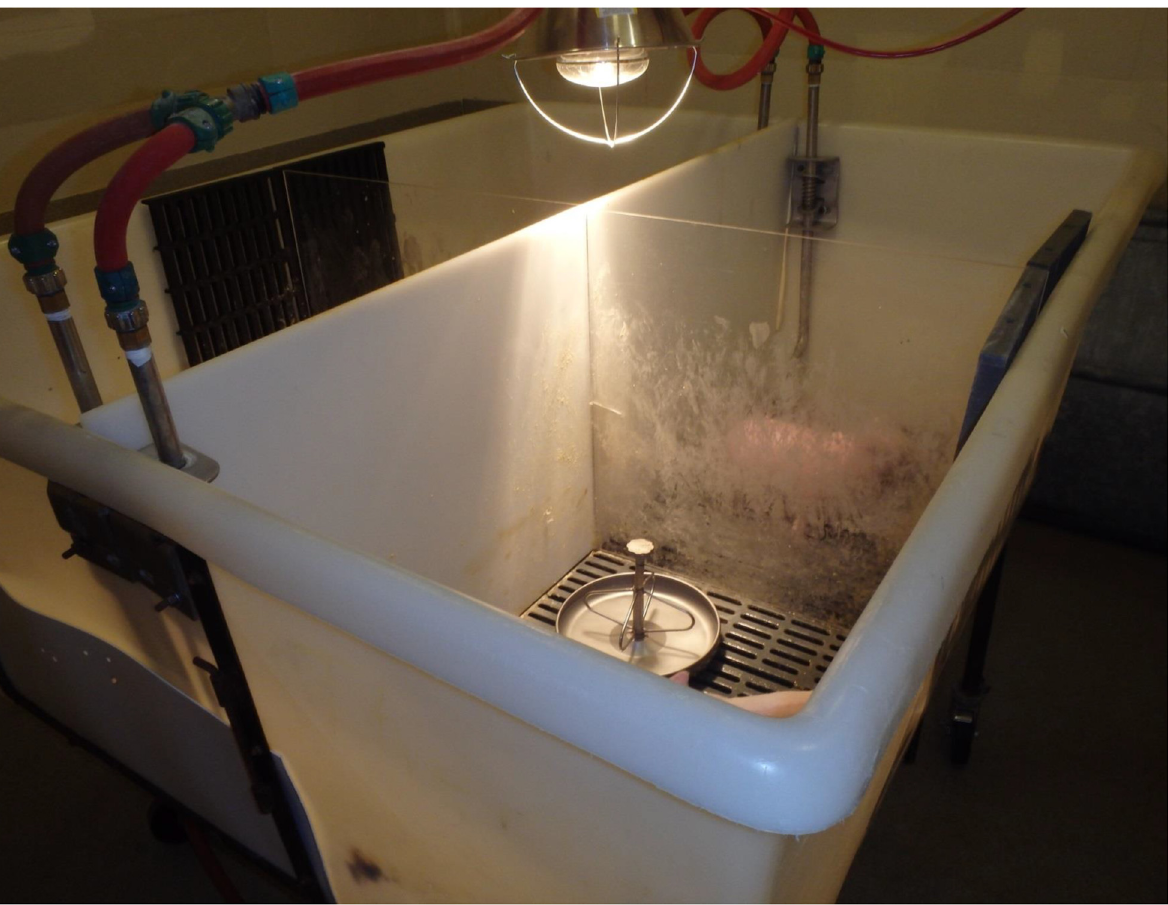
Fig 1. Elevated tubs used to house 5-day-old piglets in this study. One tub was located in each room. Each tub was split into 4 compartments with one pig per compartment. Design of the tub prevented contact between pigs and movement of feces or other waste between tub compartments.